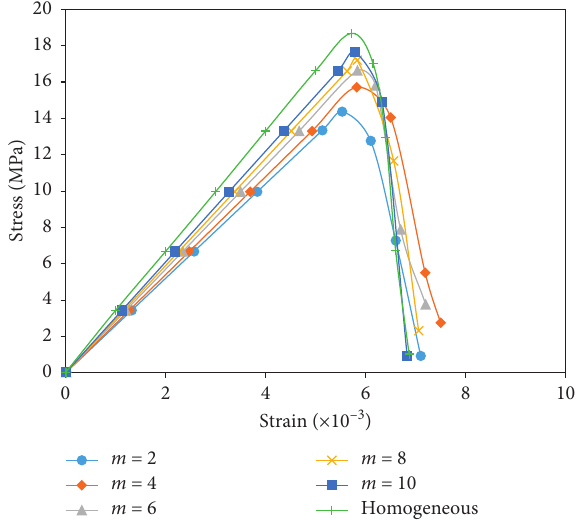
Figure 15: Stress-strain curves of No. 12 coal specimen under random assignment of cohesion by Weibull